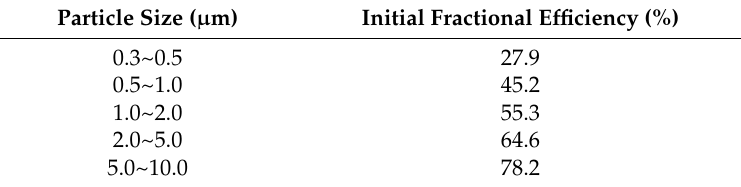
Table 1. The single pass efficiency of the Kapton filter according to size of dust